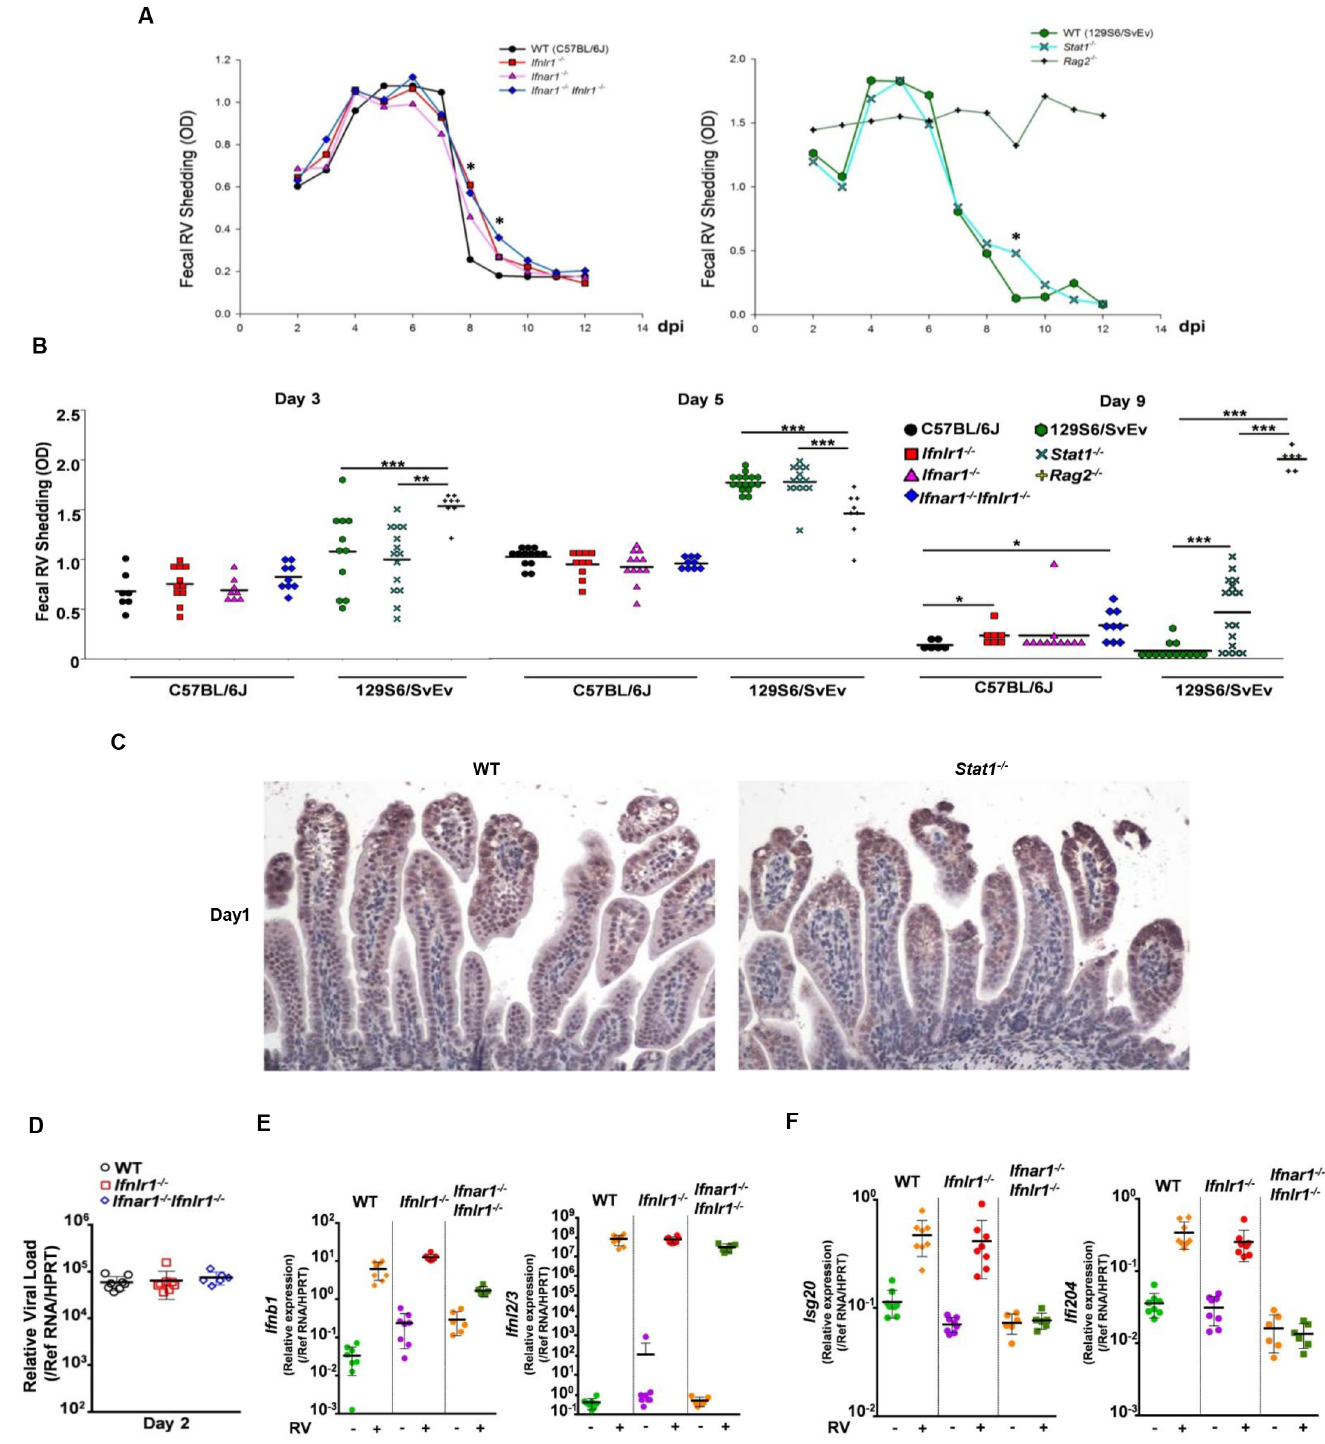
Fig 2. Murine EW-RV efficiently replicates in intestine of suckling mice, regardless of the IFN action. (A and B) Eight-day-old suckling WT (n = 6 – 13), Ifnar1 -/- (n = 7 – 11), Ifnlr1 -/- (n = 8 – 12), Ifnar1 -/- Ifnlr1 -/- (n = 8 – 12) mice (on C57BL/6J background) and WT (n = 11 – 16), Stat1 -/- (n = 13 – 16), Rag2 -/- (n = 6 – 8) mice (on 129S6/SvEv background) were orally infected with 10 4 DD 50 EW-RV. Stool samples were collected daily from 2 to 12 dpi, and EW-RV fecal shedding determined by ELISA and expressed as OD unit. The variable sample number (n) reflects the variation of animals per time point. (A) Graph of kinetics of mean fecal EW-RV shedding in indicated strains of mice on C57BL/6J or 129S6/SvEv background. (B) Dot plot presentations of EW-RV shedding